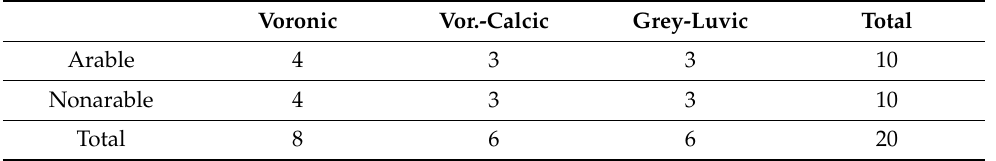
Table 1. Number of combined soil samples from arable and non-arable sites belonging to Voronic, Vorony-Calcic and Grey-Luvic subtypes of Chernozem. Voronic Vor.-Calcic Grey-Luvic Total Arable 4 3 3 10 Nonarable 4 3 3 10 Total 8 6 6